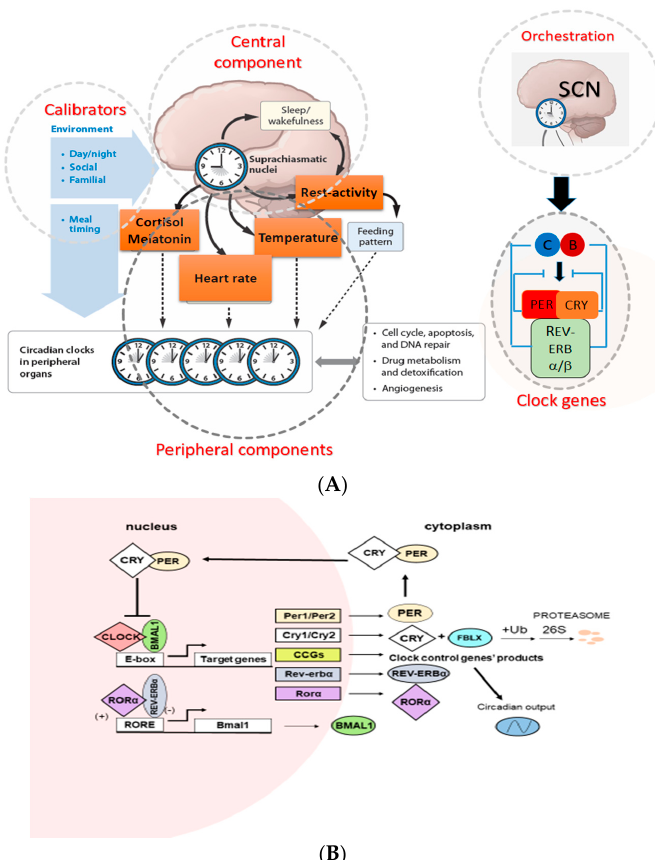
Figure 1. Hierarchical organization of the CTS and its calibrators in mammals. ( A ) The CTS consists of three components: an input component, a clockwork and output component. The input component mediated at the macroscopic level by the visual perception of light. Additionally, timing of the meal and social interaction are considered as the input, which they act as Zeitgeber. The second one, the master circadian clock is located in the hypothalamus as a pair of neuron clusters known as the suprachiasmatic nuclei (SCN). The circadian clock in SCN is entrained at precisely 24-h by environmental factors. The output component where SCN synchronizes and coordinates the molecular clocks in the peripheral tissues with a complex interplay between behavioral, neuroendocrine and neuronal pathways as well as SCN-generated physiological rhythms such as body temperature and rest-activity rhythms, heart rate, cortisol and melatonin secretion called as circadian biomarkers. Molecular clocks rhythmically control xenobiotic metabolism and detoxification, cell cycle, apoptosis, DNA repair, and angiogenesis over a 24-h period. Adapted from [30]. ( B ) Circadian oscillator is composed of interlocked positive and negative transcriptional feedback loops. In positive transcriptional feedback loops this CLOCK or NPAS4 and BMAL1 form a dimer and bind E-box of the clock controlled genes (CCGs) including Per and Cry . Then CRY and PER along with casein kinase ε (CKI ε ) form a trimeric complex and moves into nucleus, where it suppresses the activity of BMAL:CLOCK activity, which forms negative transcriptional feedback loop. A second feedback loop is formed by the action of orphan receptors, ROR α and REV-ERB α proteins, on Bmal1 transcription. ROR α and REV-ERB activate and repress transcription of Bmal1 through their competitive action on response elements (ROREs) on the Bmal1 promoter, respectively. Adapted from